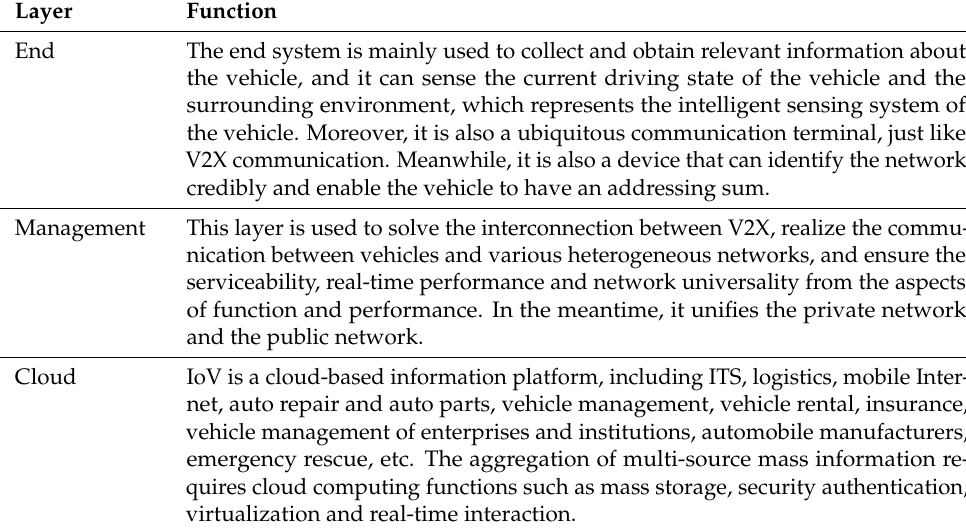
Table 2. Architecture of